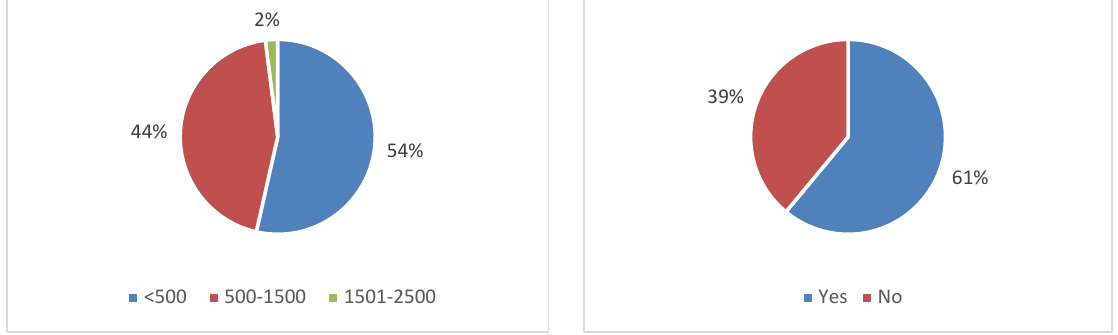
Fig. 1c. Gross monthly expenditure Fig. 1d. Sufficiency of income Fig. 1. Personal information on income